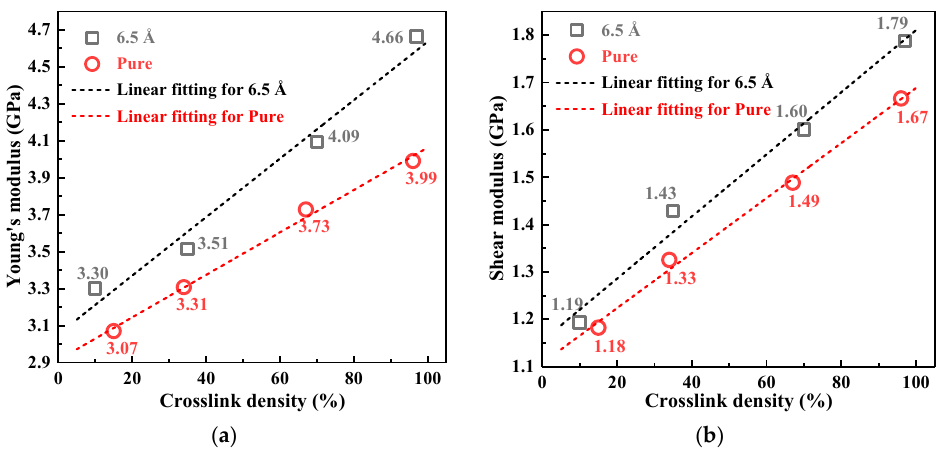
Figure 10. The static mechanical properties of the pure EP and 6.5 Å composites with different crosslinking densities. ( a ) Young’s modulus; ( b ) shear modulus.